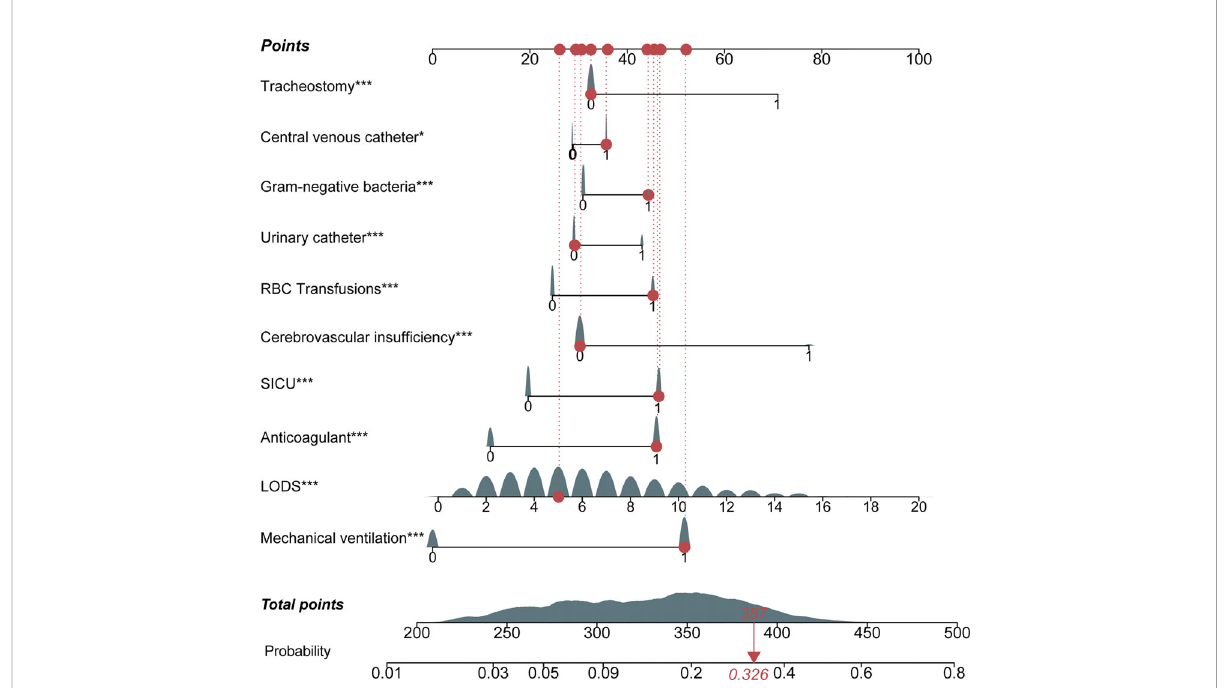
FIGURE 4 Nomogram for the prediction of intensive care unit (ICU)-acquired infections in sepsis. Each variable has corresponding points, and the total score for an individual patient could be obtained by summing up all scores. For categorical variables, 0 indicates “ no, ” while 1 means “ yes. ” The continuous variable, LODS, had continuous points. LODS, Logistic Organ Dysfunction Score; SICU, surgical ICU.